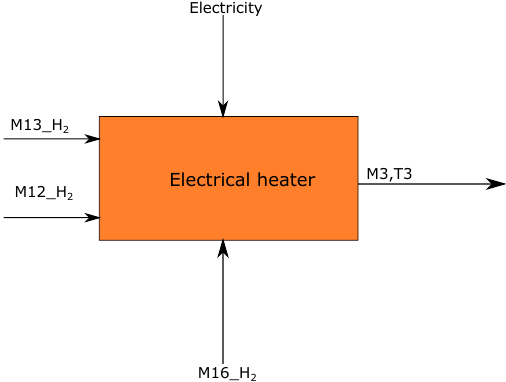
Figure 8. Mass and energy balance through the electrical heating unit for hydrogen